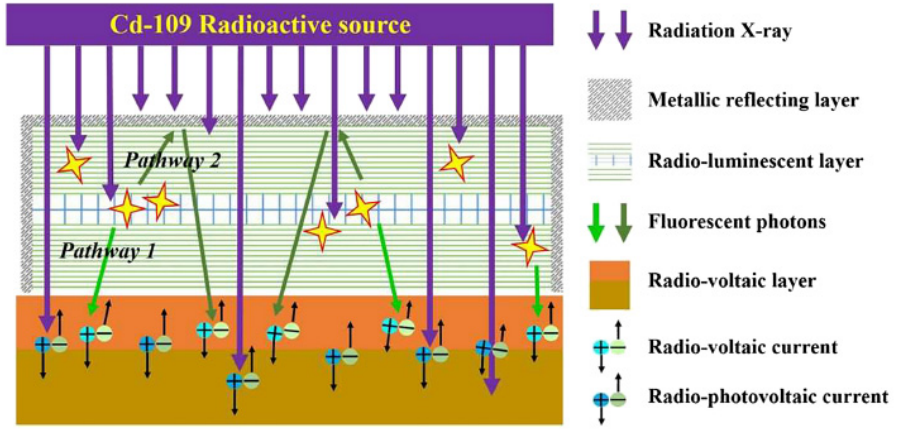
Figure 11. The schematic of Cd ‐ 109 dual ‐ effect nuclear battery. Copyright permission from.[132].